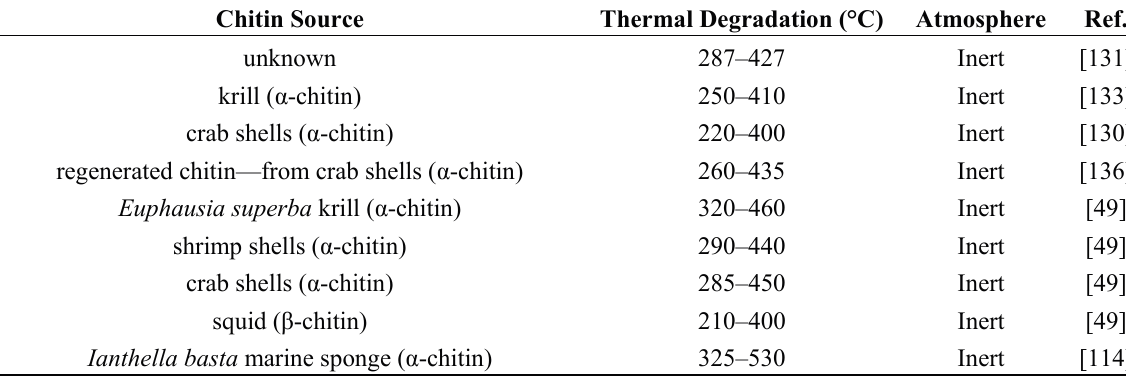
Table 1. Comparison of thermal stability for chitins from different